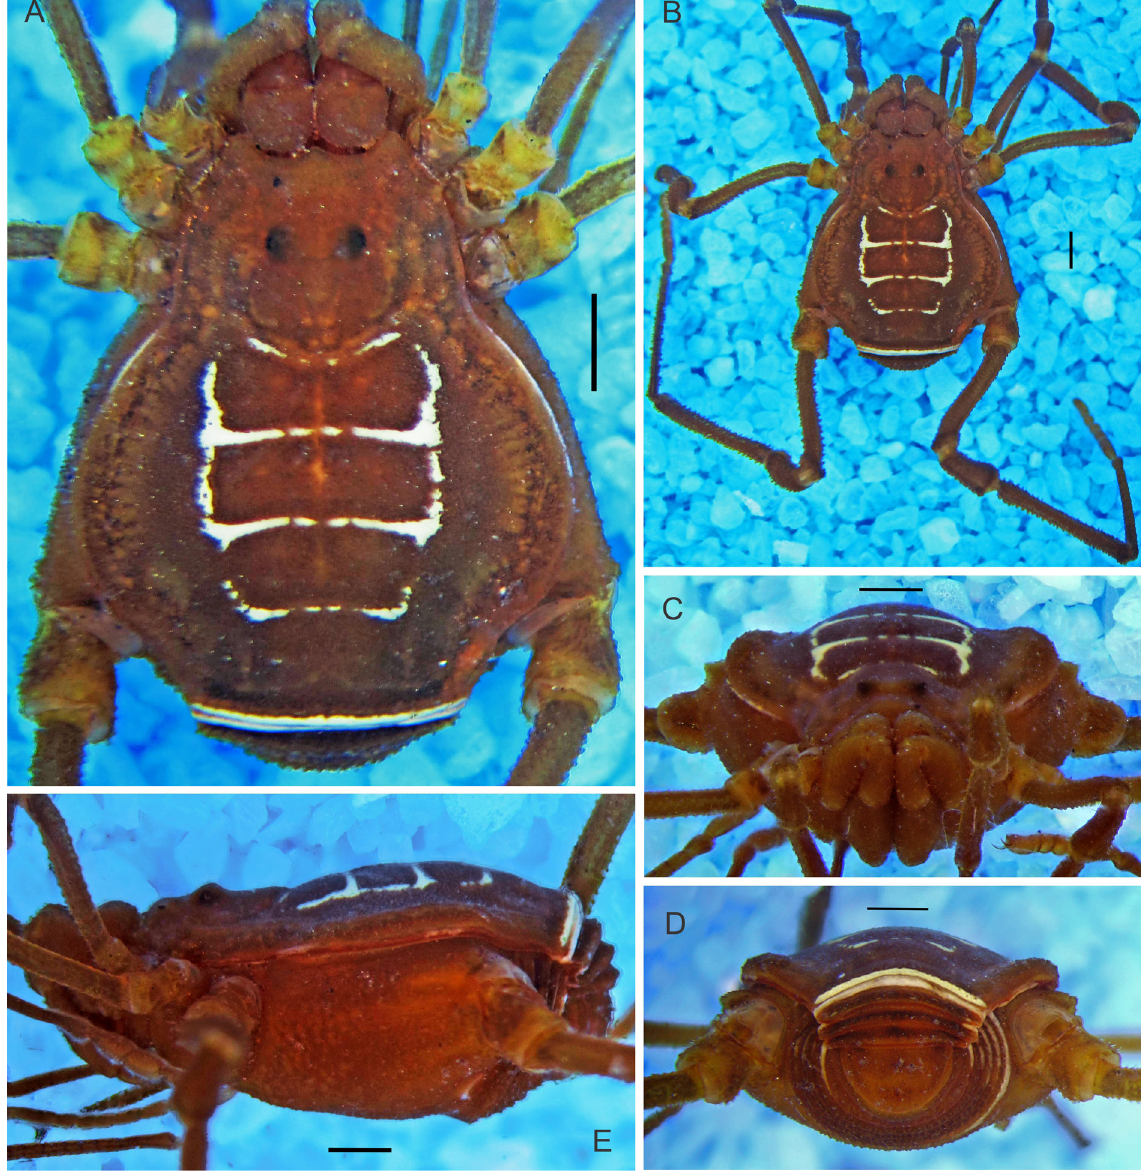
Fig. 19. Eulibitia maculata Roewer, 1912, ♂ (ICN-AO 93), habitus. A . Dorsal view. B . Panoramic, dorsal view. C . Frontal view. D . Posterior view. E . Lateral view. Scale bars: 1